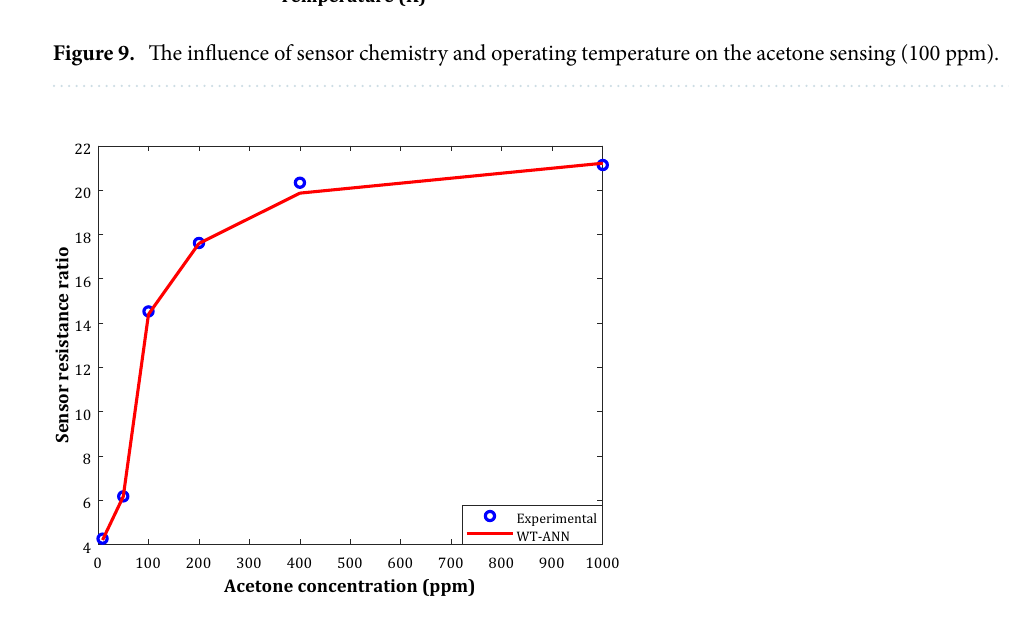
Figure 10. The effect of acetone concentration on the performance of the highest sensitive sensor (0.15 Fe 2 O 3 ) at 473